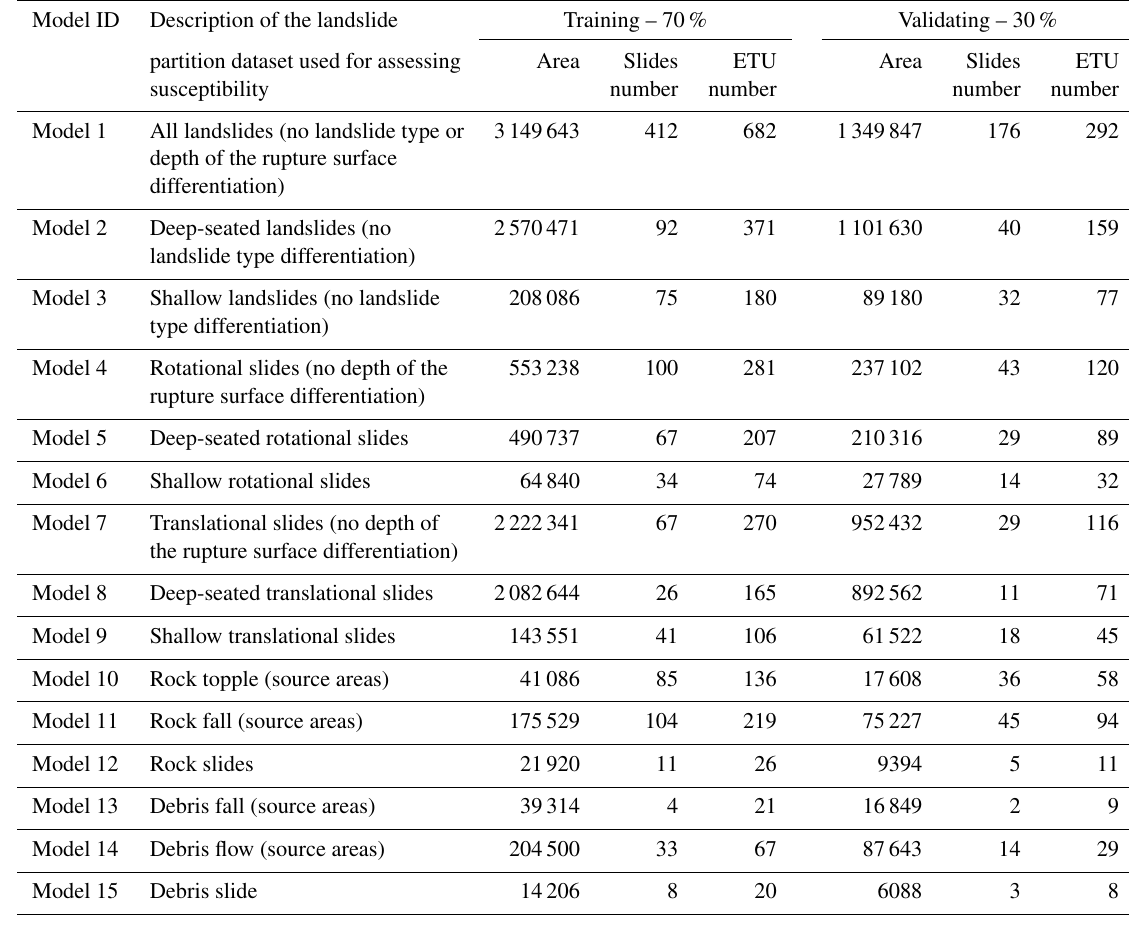
Table 3. Predictive susceptibility model strategy and landslide inventory dataset